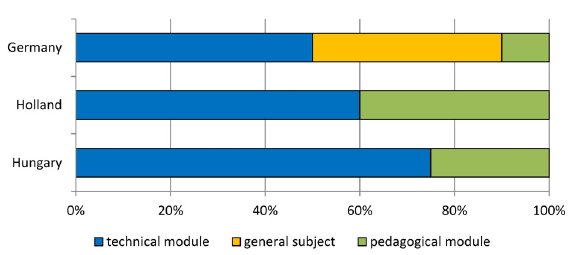
Figure 1. Proportions of the main modules in parallel technical teacher